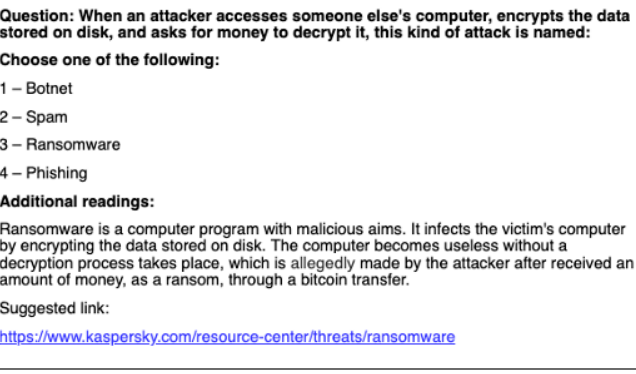
Figure 4. Example of the question layout for self-diagnosis web